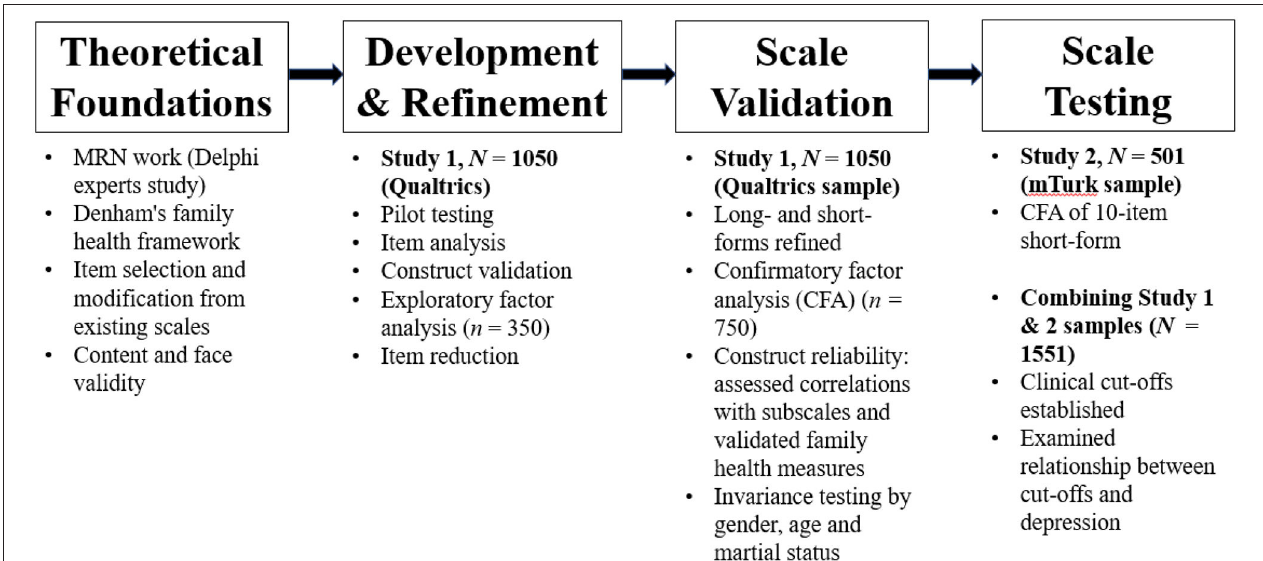
FIGURE 1 | Family health scale development (long- and short-form) methods summary.